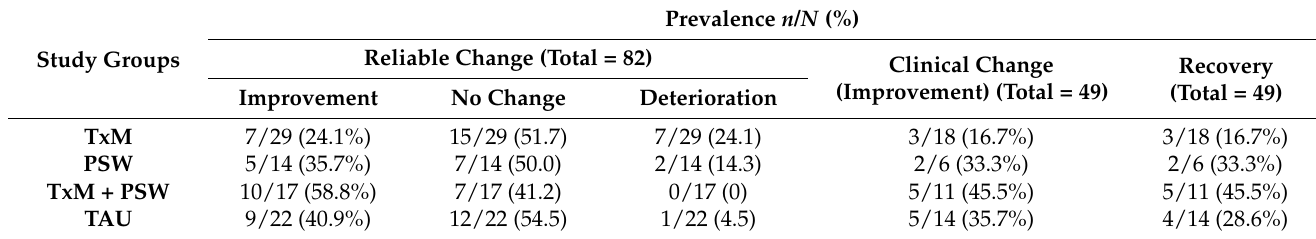
Figure 2. Distribution of CORE-OM domains over the six-month study period after controlling for baseline scores (adjusted means with standard error of the mean (SEM)). Table 2. The change parameters of CORE-OM all-item analysis across the four study arms from baseline to six